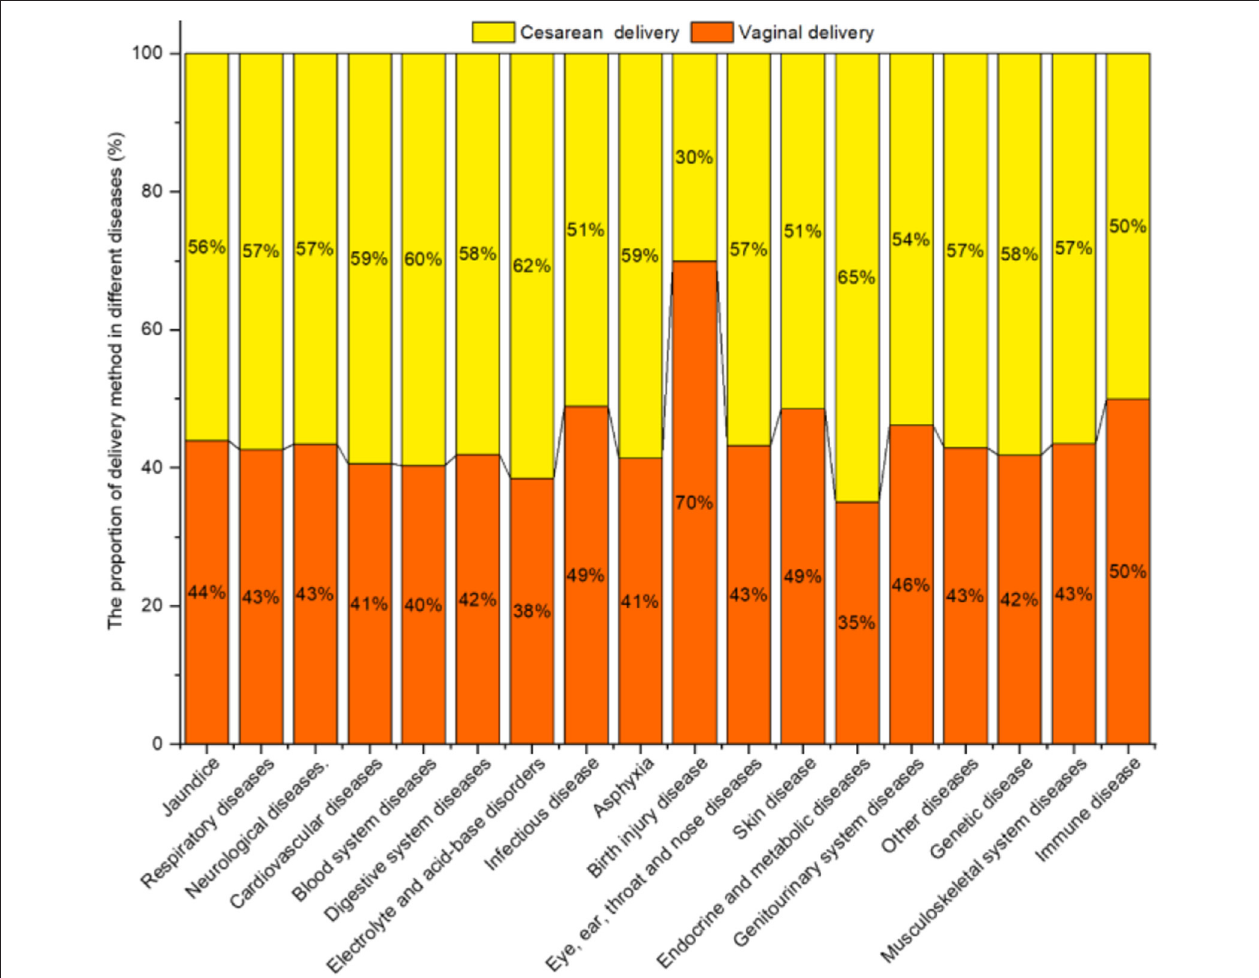
FIGURE 8 | Neonatal diseases and distribution by delivery